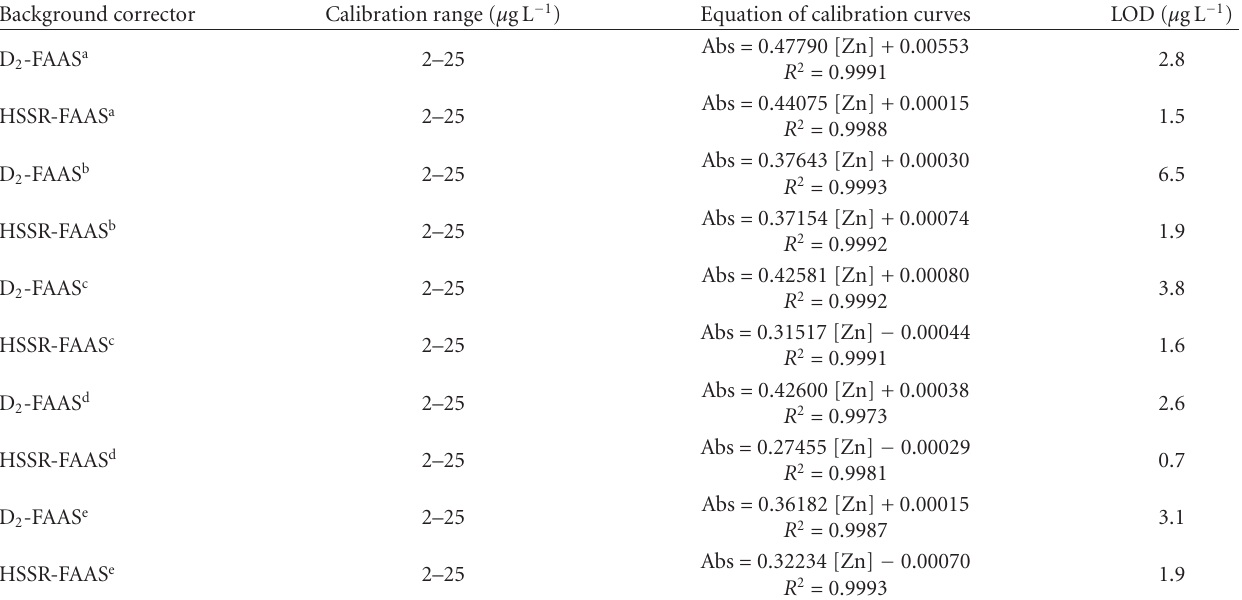
Table 2: Calibration data for the determination of